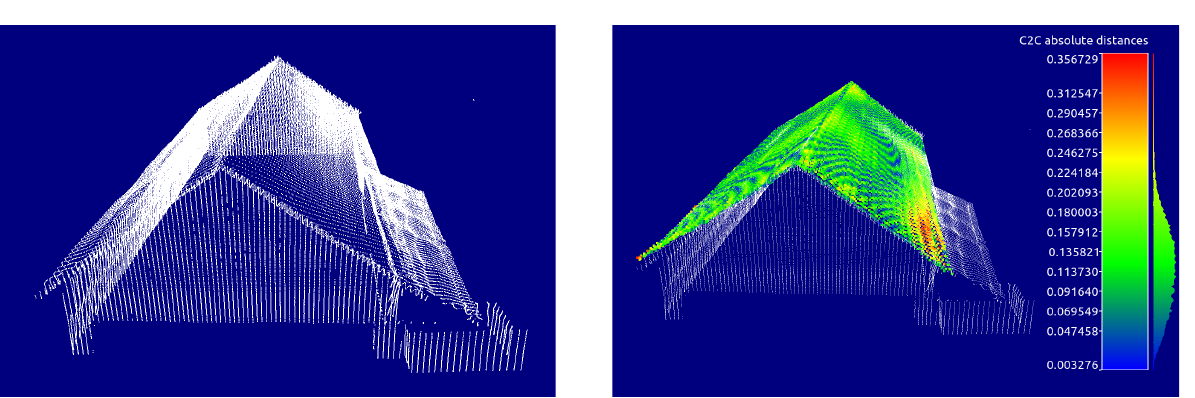
Figure 6: Hangar reference model generated from LiDAR mea- surements taken from the ground.